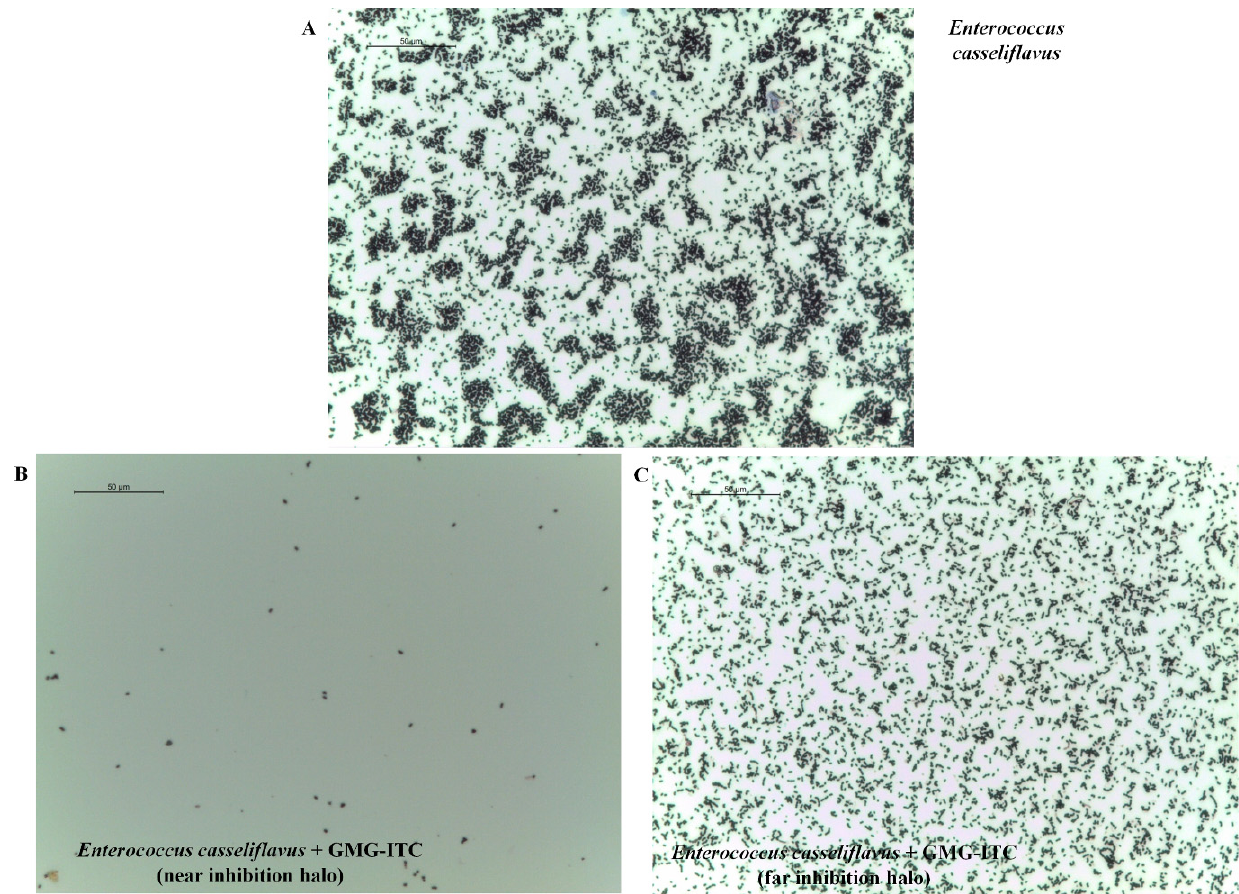
Figure 2. E. casseliflavus susceptibility to GMG-ITC treatment. E. casseliflavus was incubated with GMG-ITC for 24 h and a loopful near and far the inhibition halo was taken to perform Gram staining. The results show that a very low bacterial growth is present in correspondence of the inhibition halo ( B ). Moreover a higher bacterial concentration has been detected far from the inhibition halo ( C ) but, anyway, a lower number of bacterial per cm 2 was detected in comparison to plates where antibiotic treatment was not applied ( A ). Images were taken using a 40× objective, scale bar = 50